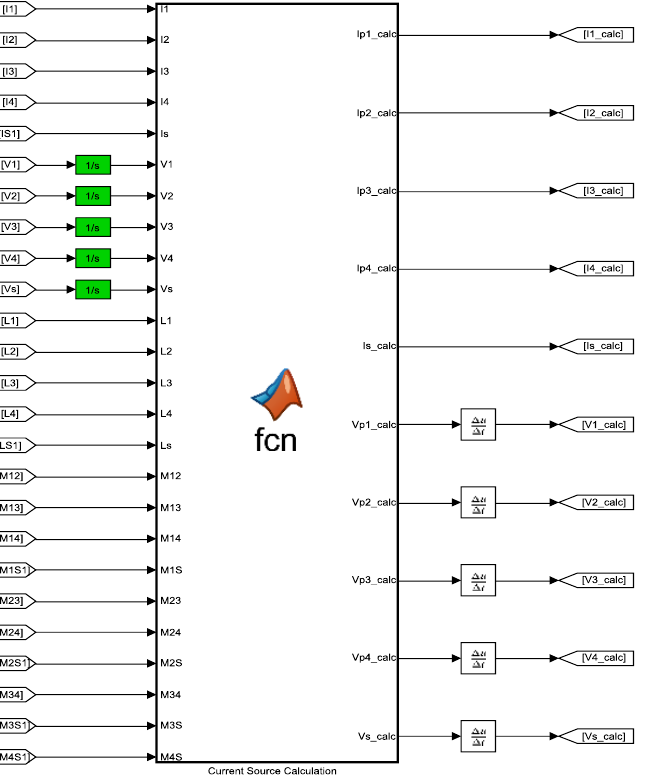
Figure A4. Model of the magnetic couplers.